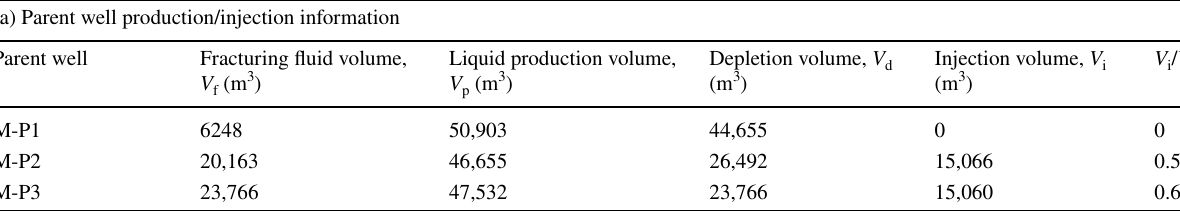
Table 7 Well completion, production and injection information of the parent and infill wells (the M region) (a) Parent well production/injection information Parent